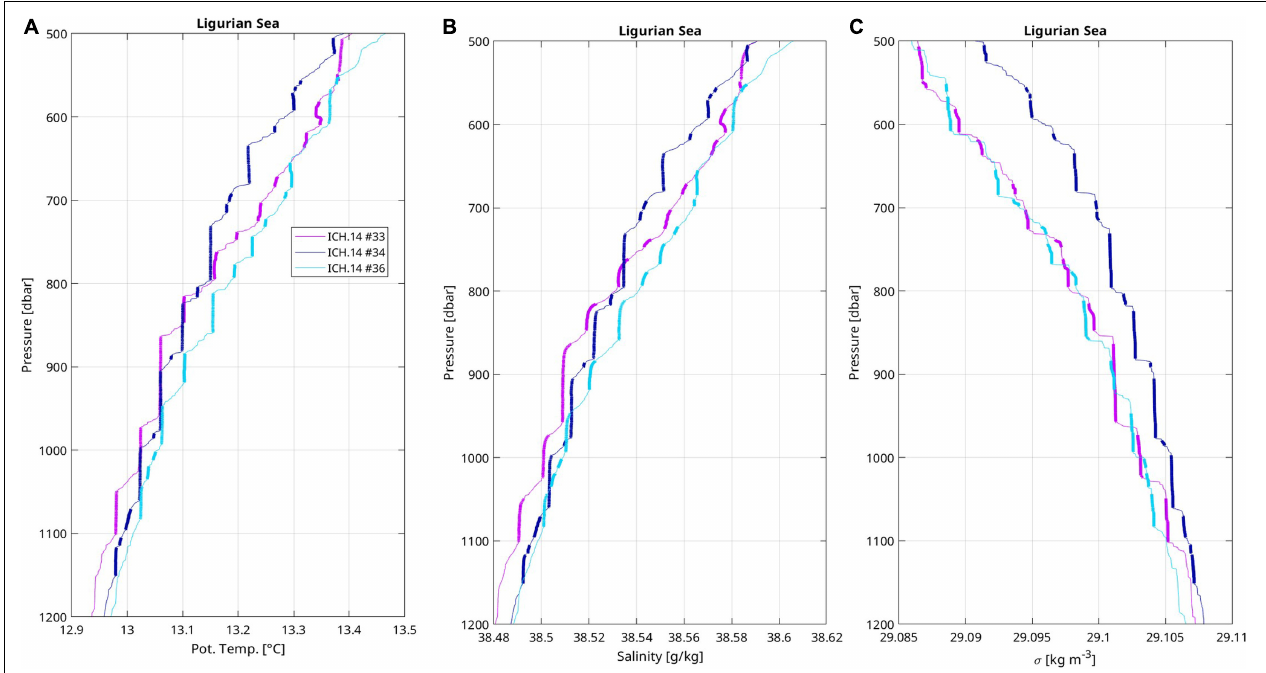
FIGURE 4 | Vertical profiles in staircases of (A) potential temperature, (B) salinity, and (C) potential density of stations located in the Ligurian sea during ICHNUSSA 2014. Station numbers are indicated in the figure legend (A) and located on the map ( Figure 1 ). Layers are emphasized by thick lines with weak vertical gradient segments.